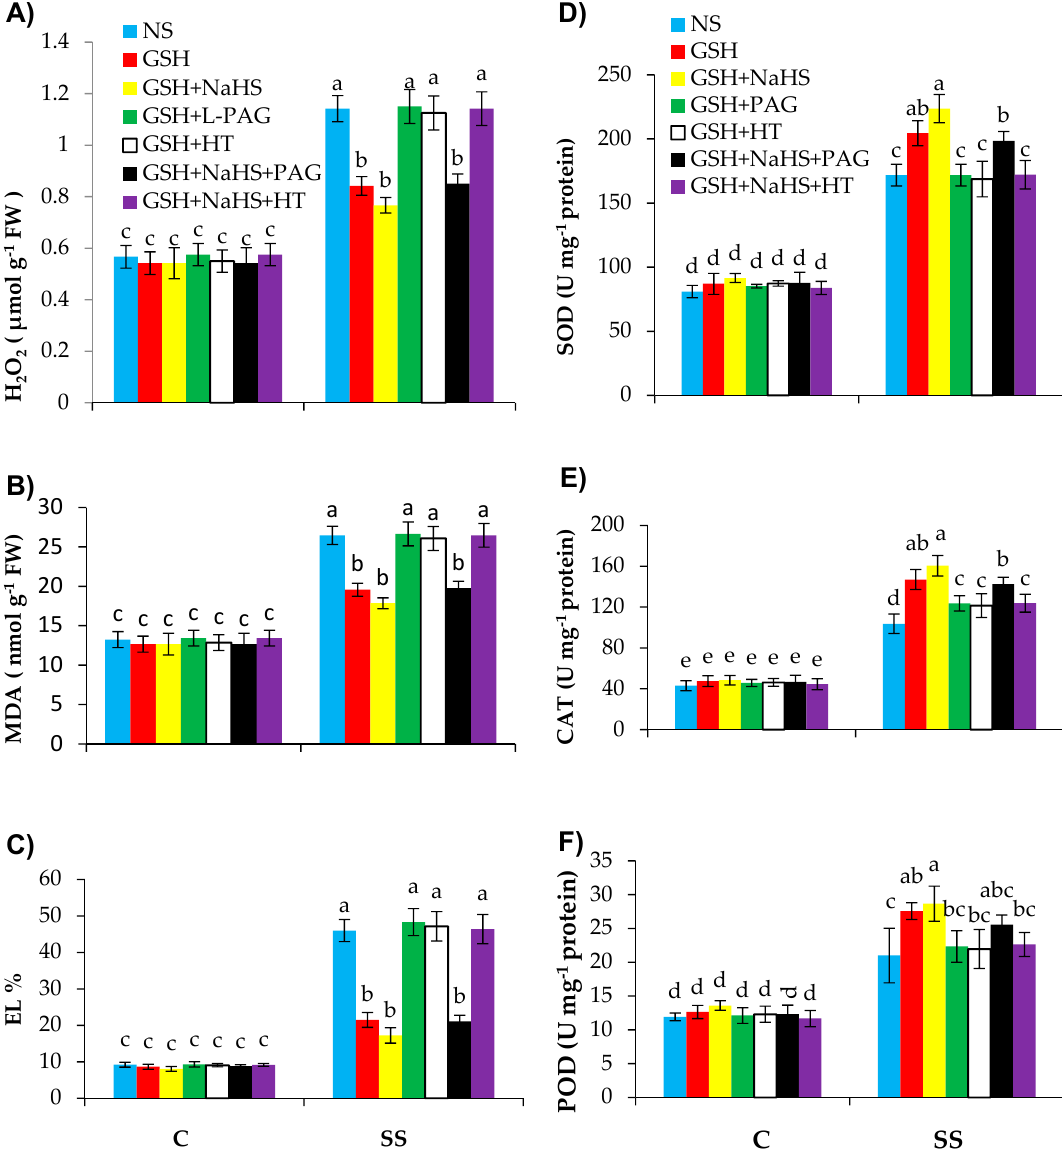
Figure 6. Hydrogen peroxide (H 2 O 2 ; ( A )), and malondialdehyde (MDA; ( B )) on a fresh weight (FW) basis, and electrolyte leakage (EL; ( C )) and activities of superoxide dismutase (SOD ( D )), catalase (CAT ( E )), and peroxidase (POD ( F )) in pepper plants grown under control (C) and salinity stress (SS 100 mmol L − 1 NaCl), sprayed with glutathione (1.0 mmol L − 1 GSH) or sodium hydrosulfide (0.2 mmol L − 1 NaHS) alone or together, combined with a 0.1 mmol L − 1 scavenger of H 2 S, hypotaurine (0.1 mmol L − 1 HT), or inhibitor of l -DES, dl -propargylglycine (0.3 mmol L − 1 PAG). (Mean ± SE). Mean values carrying di ff erent letters within each parameter di ff er significantly ( p ≤ 0.001) based on Duncan’s multiple range test.